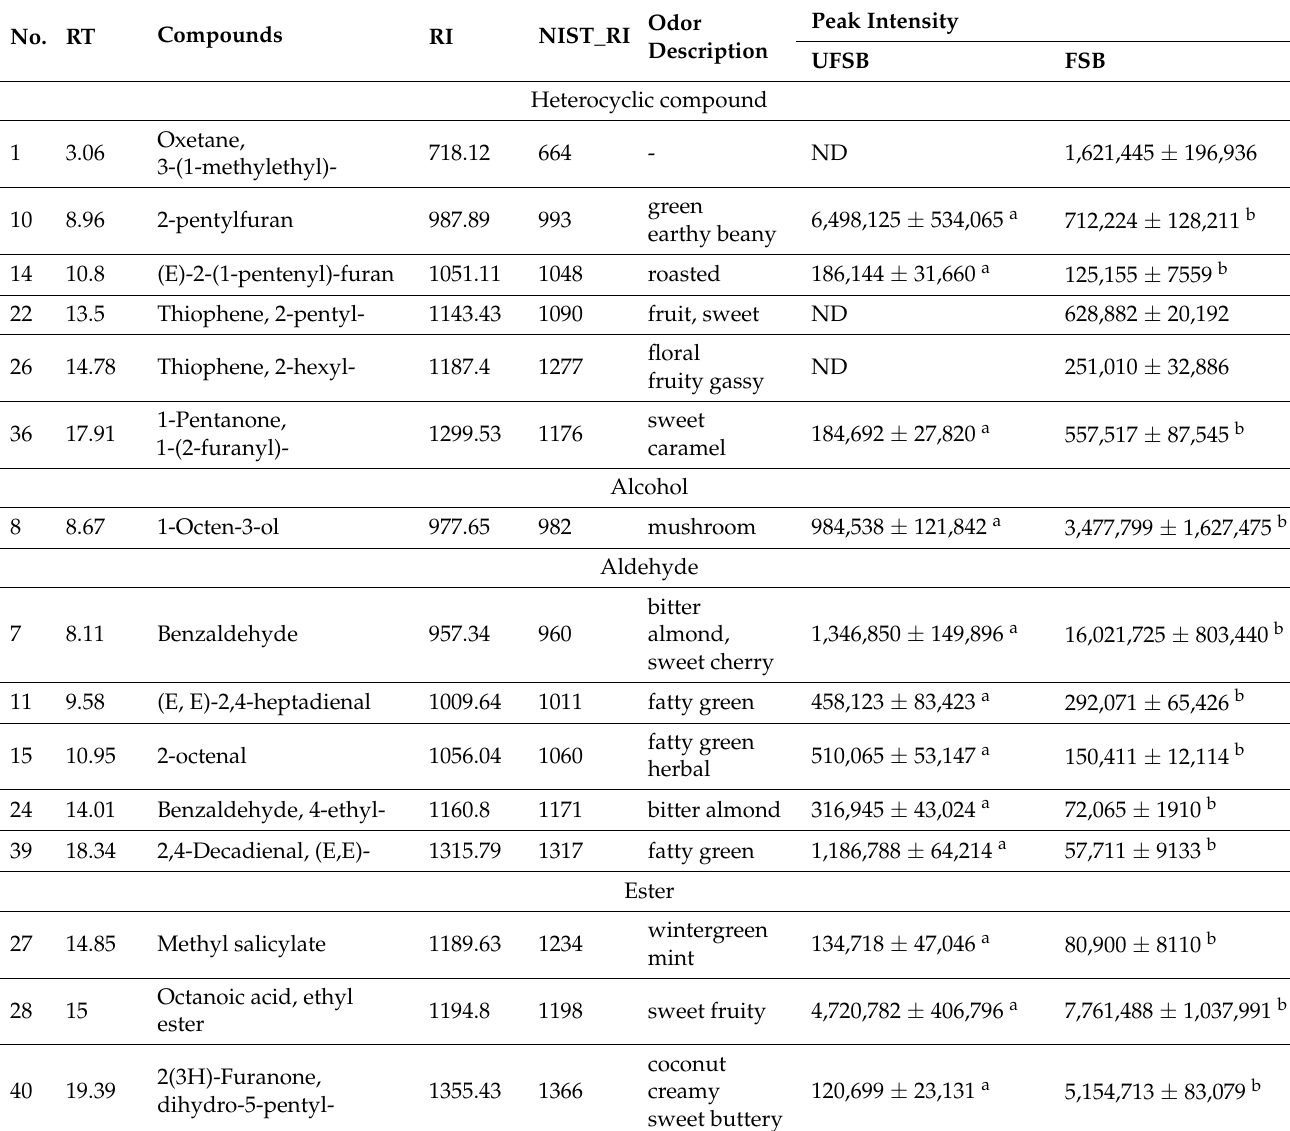
Table 3. Identification of the volatile compounds in fermented soy beverage by